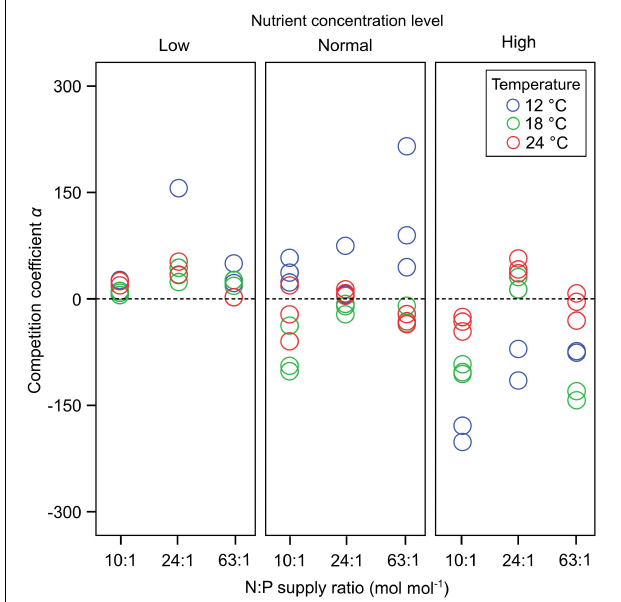
TABLE 3 | Results of the selected GLMMs testing for the effects of temperature, N:P supply ratios, and nitrate concentrations on interaction coefficient α